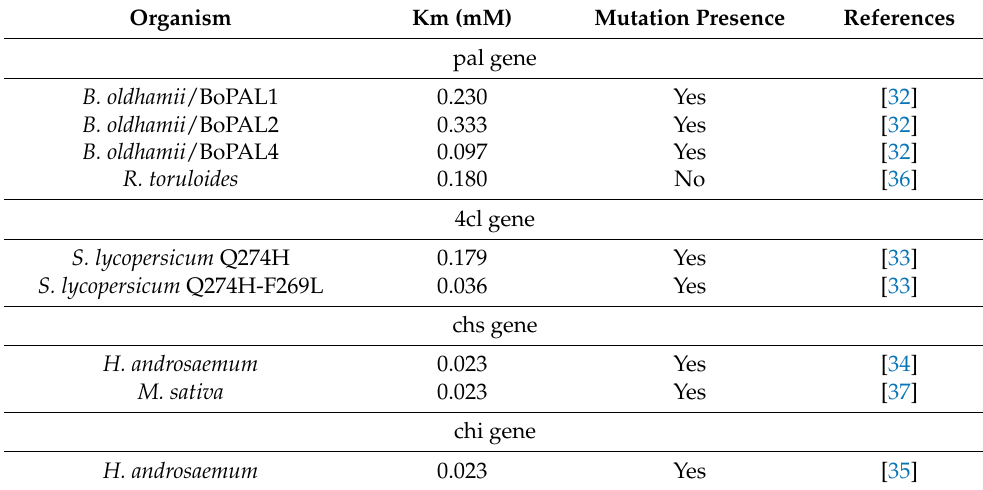
Table 3. List of possible organisms for each gene found for the synthesis of (2 S )-naringenin. Organism